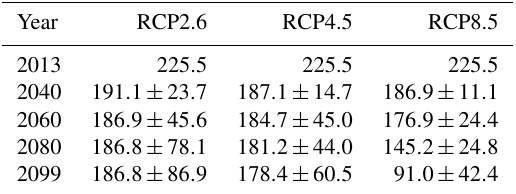
Table 2. Projected ice volumes in cubic metres for different sce- narios and years: mean and standard deviation obtained by forcing SICOPOLIS for 23 climate models.